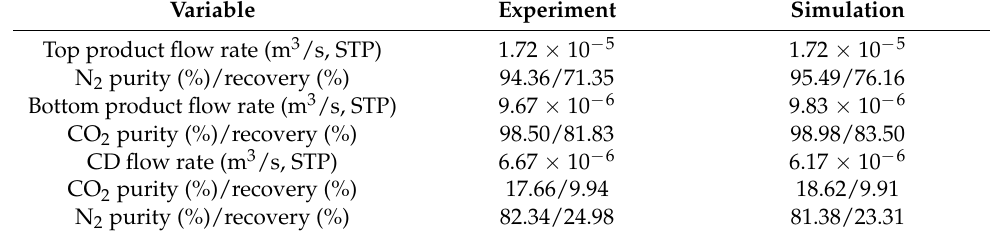
Table 11. Results of the single-bed three-step process.